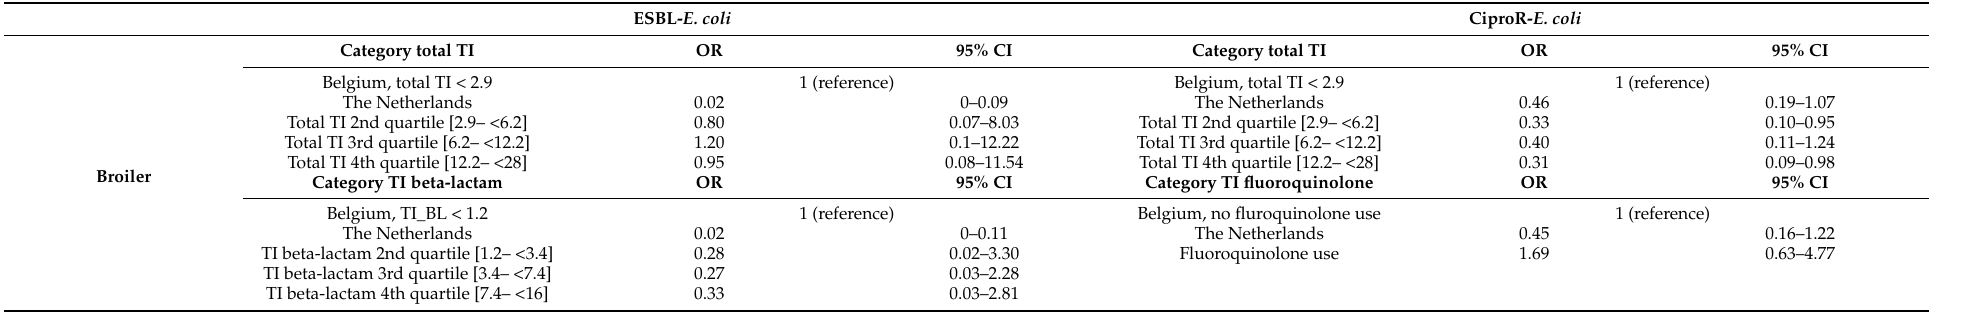
Table 2. Associations between antibiotic use and prevalence of resistant samples in broiler and pig farms using a mixed effects logistic regression model. The model showed no association of any level of antibiotic use with prevalence. The quantity of antibiotic use in the year preceding sampling was categorized in quartiles of treatment incidence (TI) of total antibiotic use and beta-lactam use and use or no use of fluoroquinolone